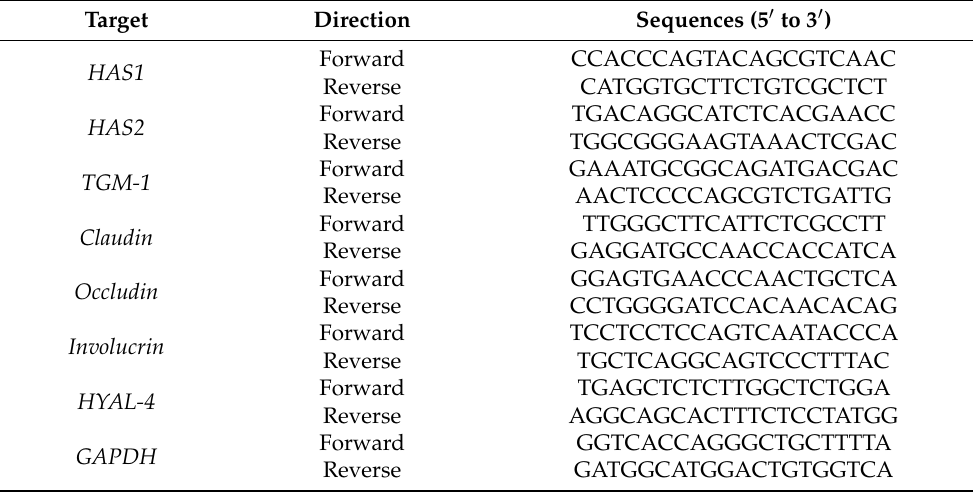
Table 1. Sequences of PCR primers used in this